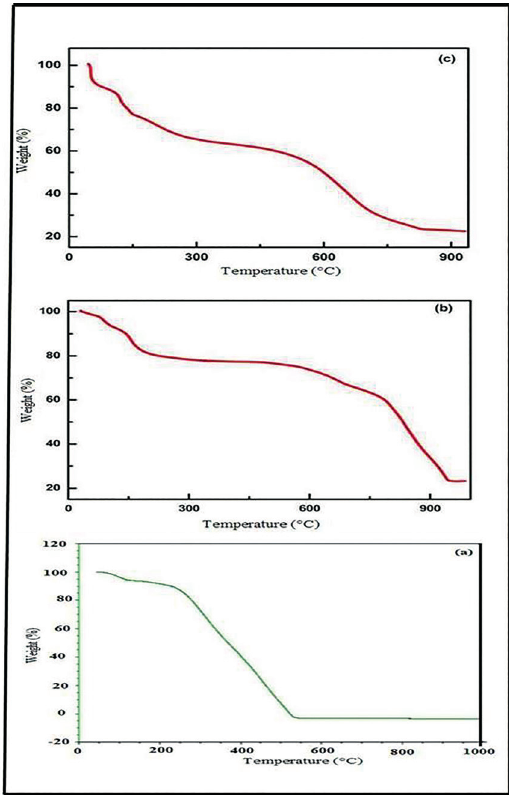
Figure 5: TGA of (a) PPY (b) nanophotoadduct (c)